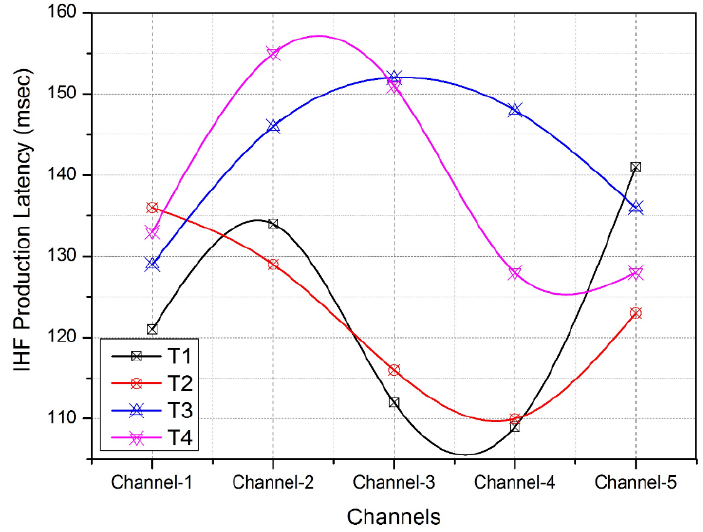
Figure 8. IHF Production Latency.